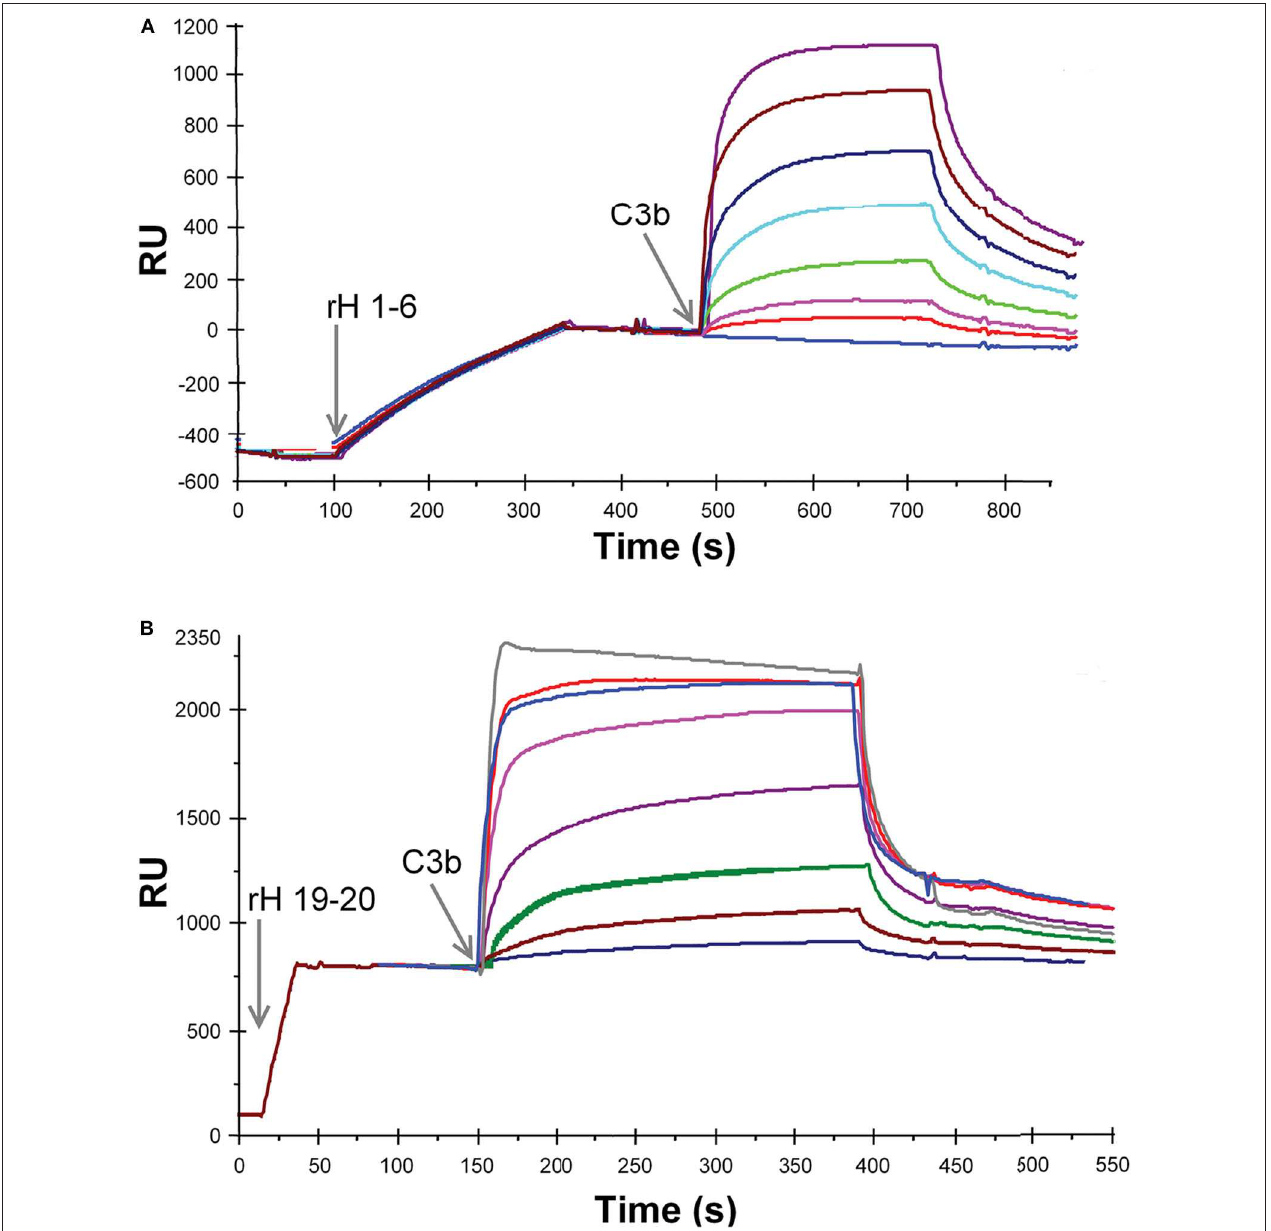
FIGURE 3 | SPR analysis of the binding of recombinant Factor H to C3b. (A) Purified rH 1-6 was attached to the NTA-Ni-coated sensor surface by injecting 20 µ l of protein (1.2 µ g/ml, in HBS-P) at a flow rate of 5 µ l/min over flow cell 1. Eight different concentrations of C3b (0, 0.014, 0.028, 0.055, 0.11, 0.22, 0.44, and 0.88 µ M C3b) in HBS-P were injected at 5 µ l/min over flow cells 1 and 2. Lower concentrations of the ligand (C3b) were used than in (B) due to the higher affinity between rH 1-6 and C3b. (B) Same as in (A) except that purified rH 19-20 was attached to the NTA-Ni surface by injecting 20 µ l of protein (3 µ g/ml, in HBS-P) at a flow rate of 20 µ l/min over flow cell 1. Eight different concentrations of C3b (0.14, 0.28, 0.57, 1.1, 12.0, 2.8, 4.3, 5.7 µ M C3b) in HBS-P were injected at 5 µ l/min over flow cells 1 and 2 (reference cell with Ni-NTA but no rH 19-20). RU (response units) shown represent the signal from flow cell 1 minus that from flow cell 2. The overlay plot